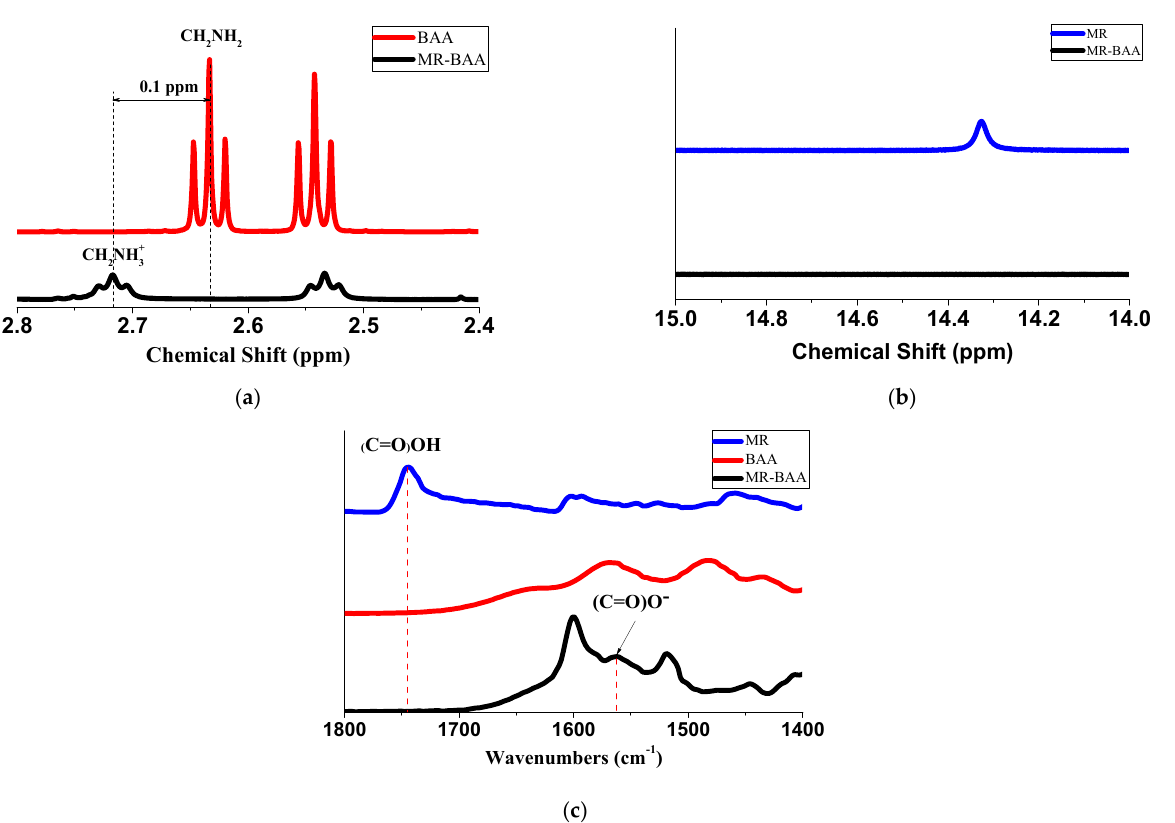
Figure 3. ( a ) 1 H NMR spectra of the methylene group attached to the terminal amine groups; ( b ) 1 H NMR spectra of the carboxylate group; and ( c ) FTIR spectra in the range of the carbonyl and carboxylate groups.